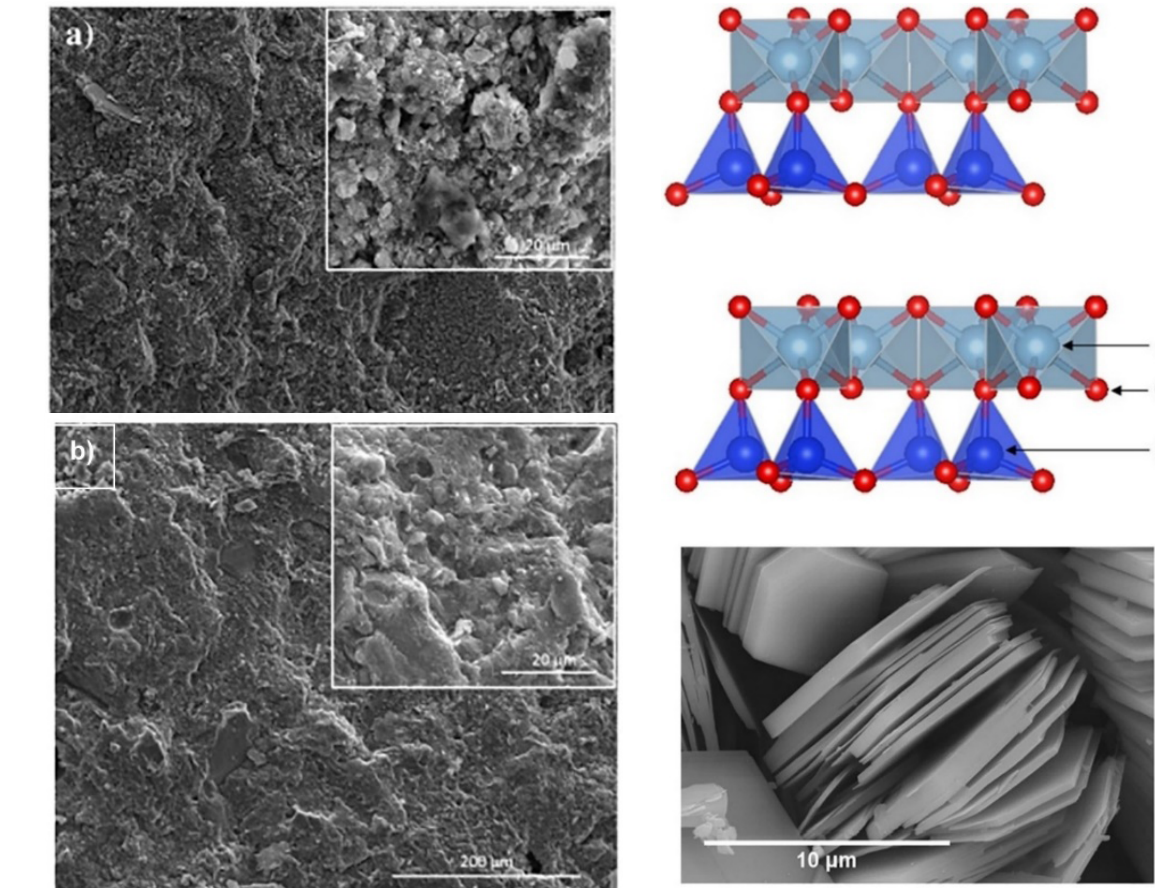
Figure 2: Micrographs of alkali-activated clay sediments showing that activation with NaOH (a) resulted in a more porous, less dense microstructure than activation with (b) Na-silicate solution (Ferone, et al., 2015).